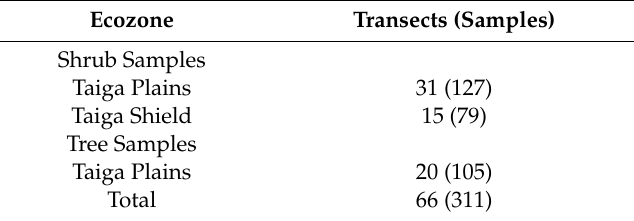
Table 1. Overview of aboveground biomass (AGB) of shrub and tree samples harvested per ecoregion. Ecozone Transects (Samples) Shrub